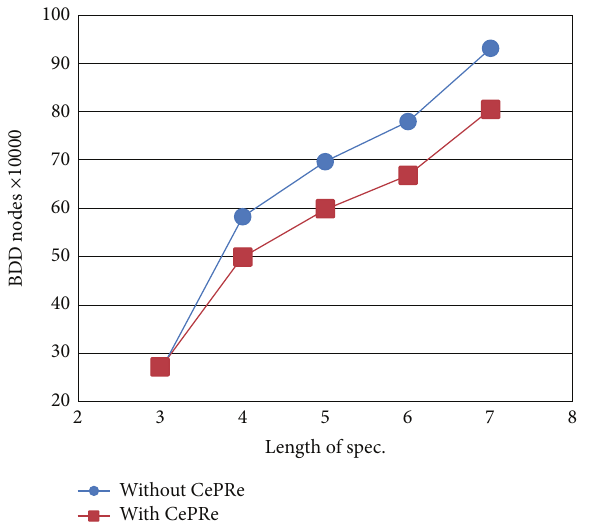
Figure 1: Results on the scale of BDD nodes in random BDD-MC experiments.